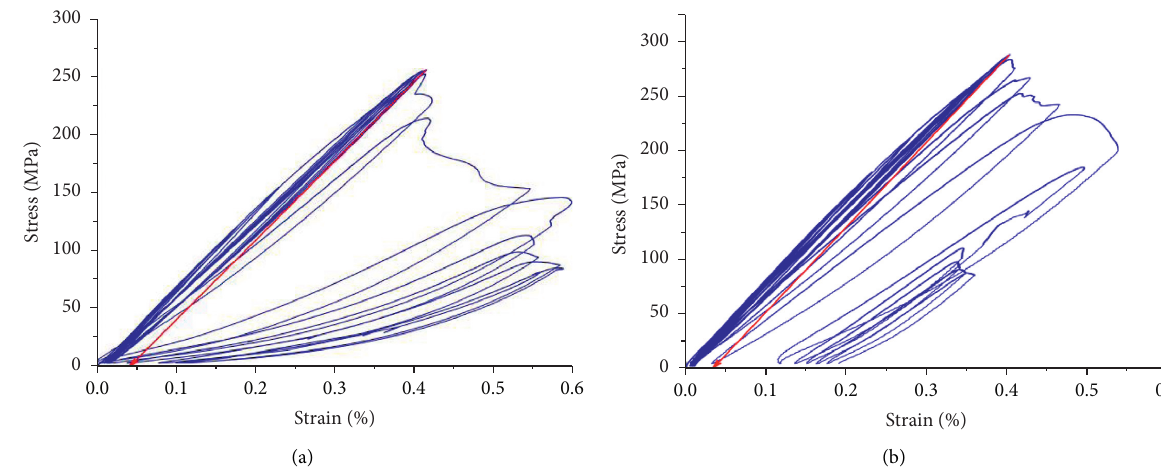
Figure 6: Typical stress-strain loading and unloading curves of granite. (a) 20MPa. (b) 30MPa.